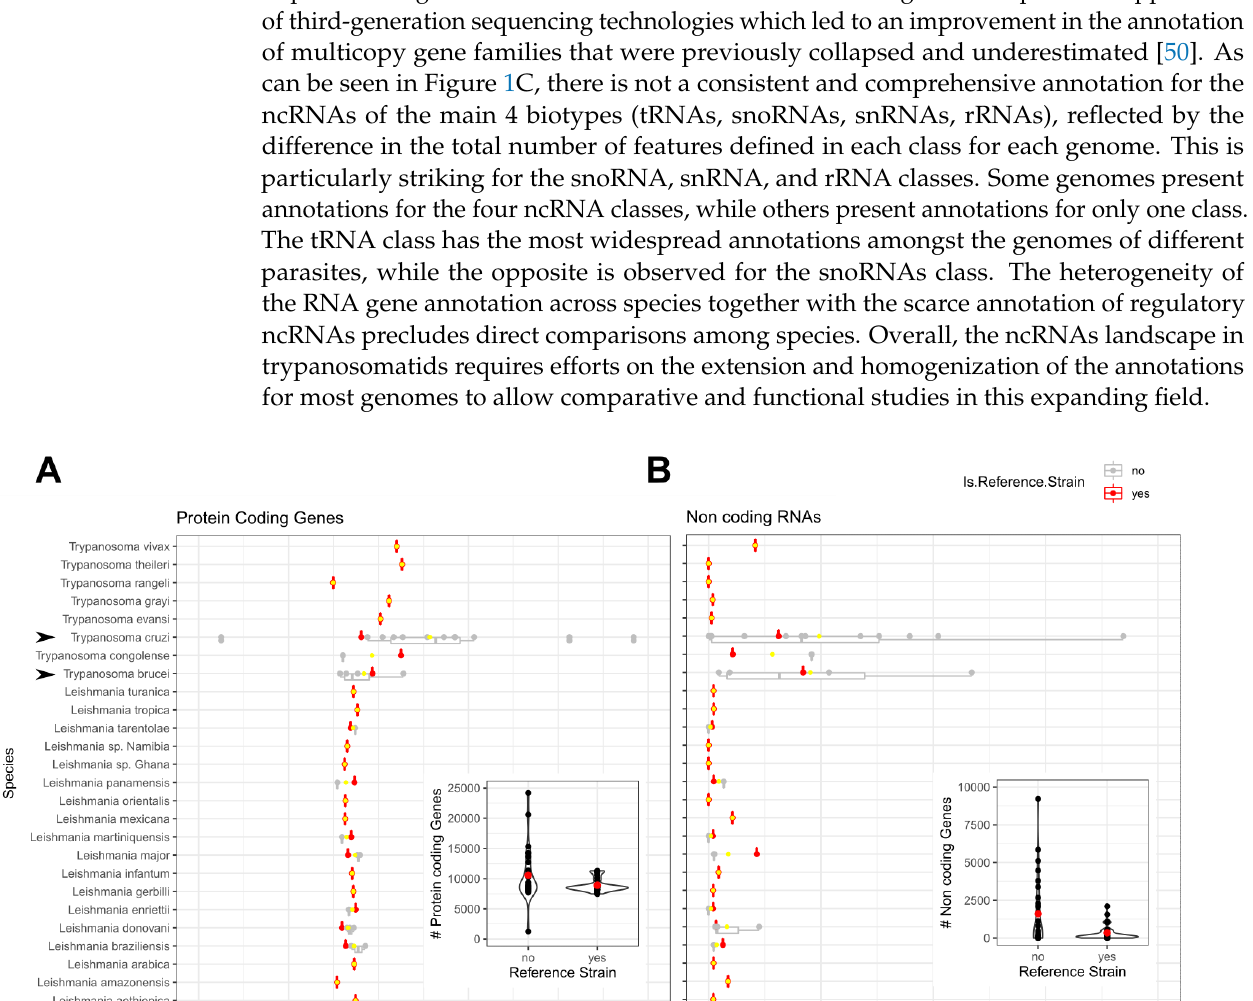
Figure 1. Outlook of the non-coding genomic annotations available in TriTrypDB. All Leishmania spp. and Trypanosoma spp . genomic data was obtained from TritrypDB (Release 56) for protein-cod- ing genes ( A ) and non-protein-coding genes ( B ). The inset plot presents the distribution of the num- ber of genes annotated for all genomes grouped by reference and non-reference strains. For the main